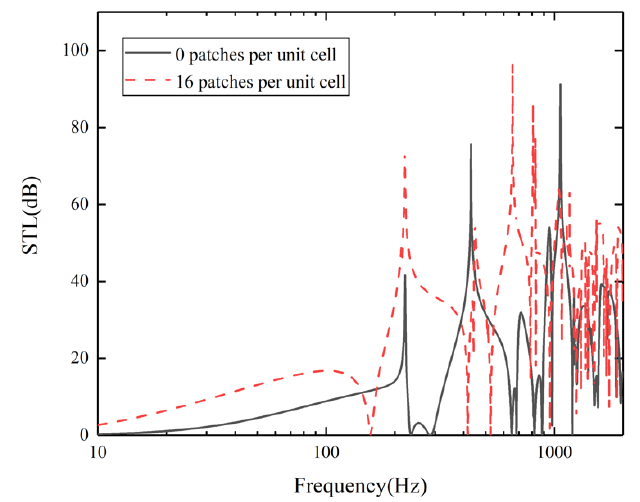
Figure 10. Comparison of the STL curves between the research model with 16 piezoelectric patches per unit cell and the comparison model without piezoelectric patches.